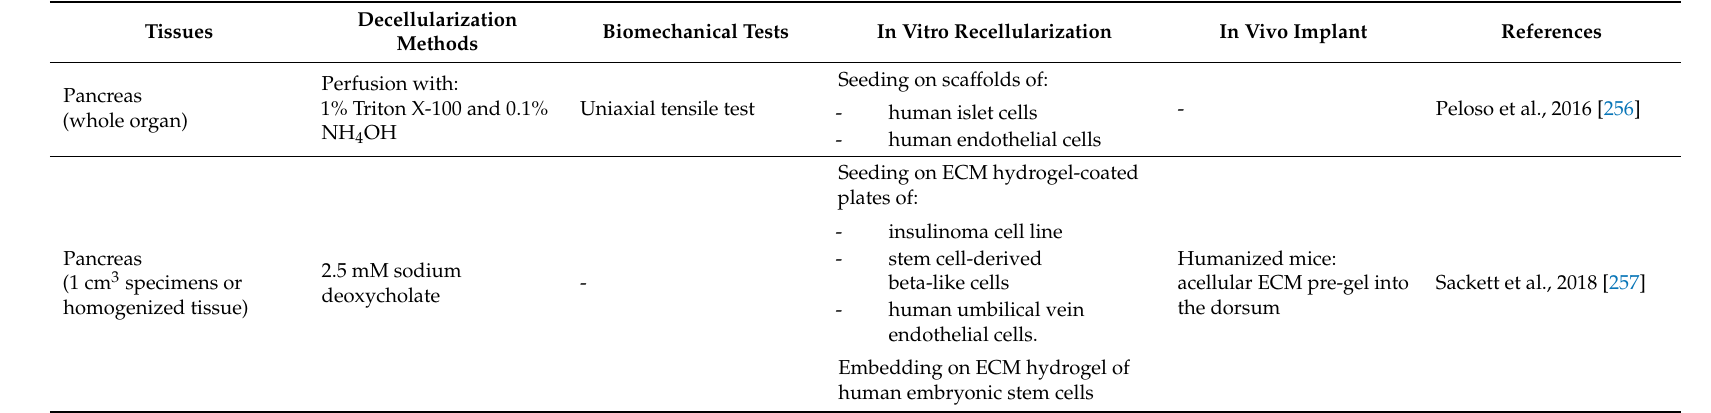
Table 8. Pancreas. Decellularization techniques, biomechanical tests, recellularization methods, and in vivo implant of human pancreatic extracellular